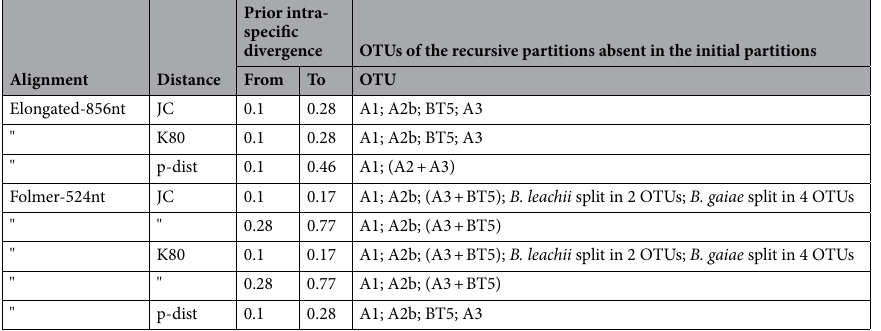
Alignment Distance